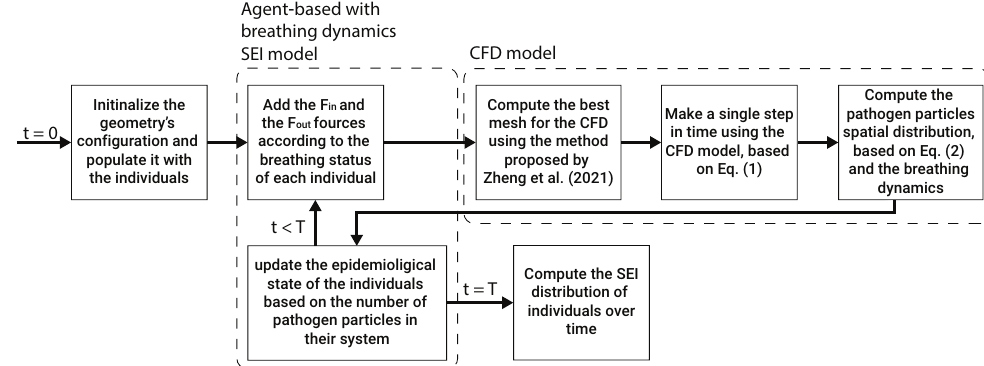
Figure 2. A schematic view of the simulator’s process, including the integration of the agent-based with the breathing